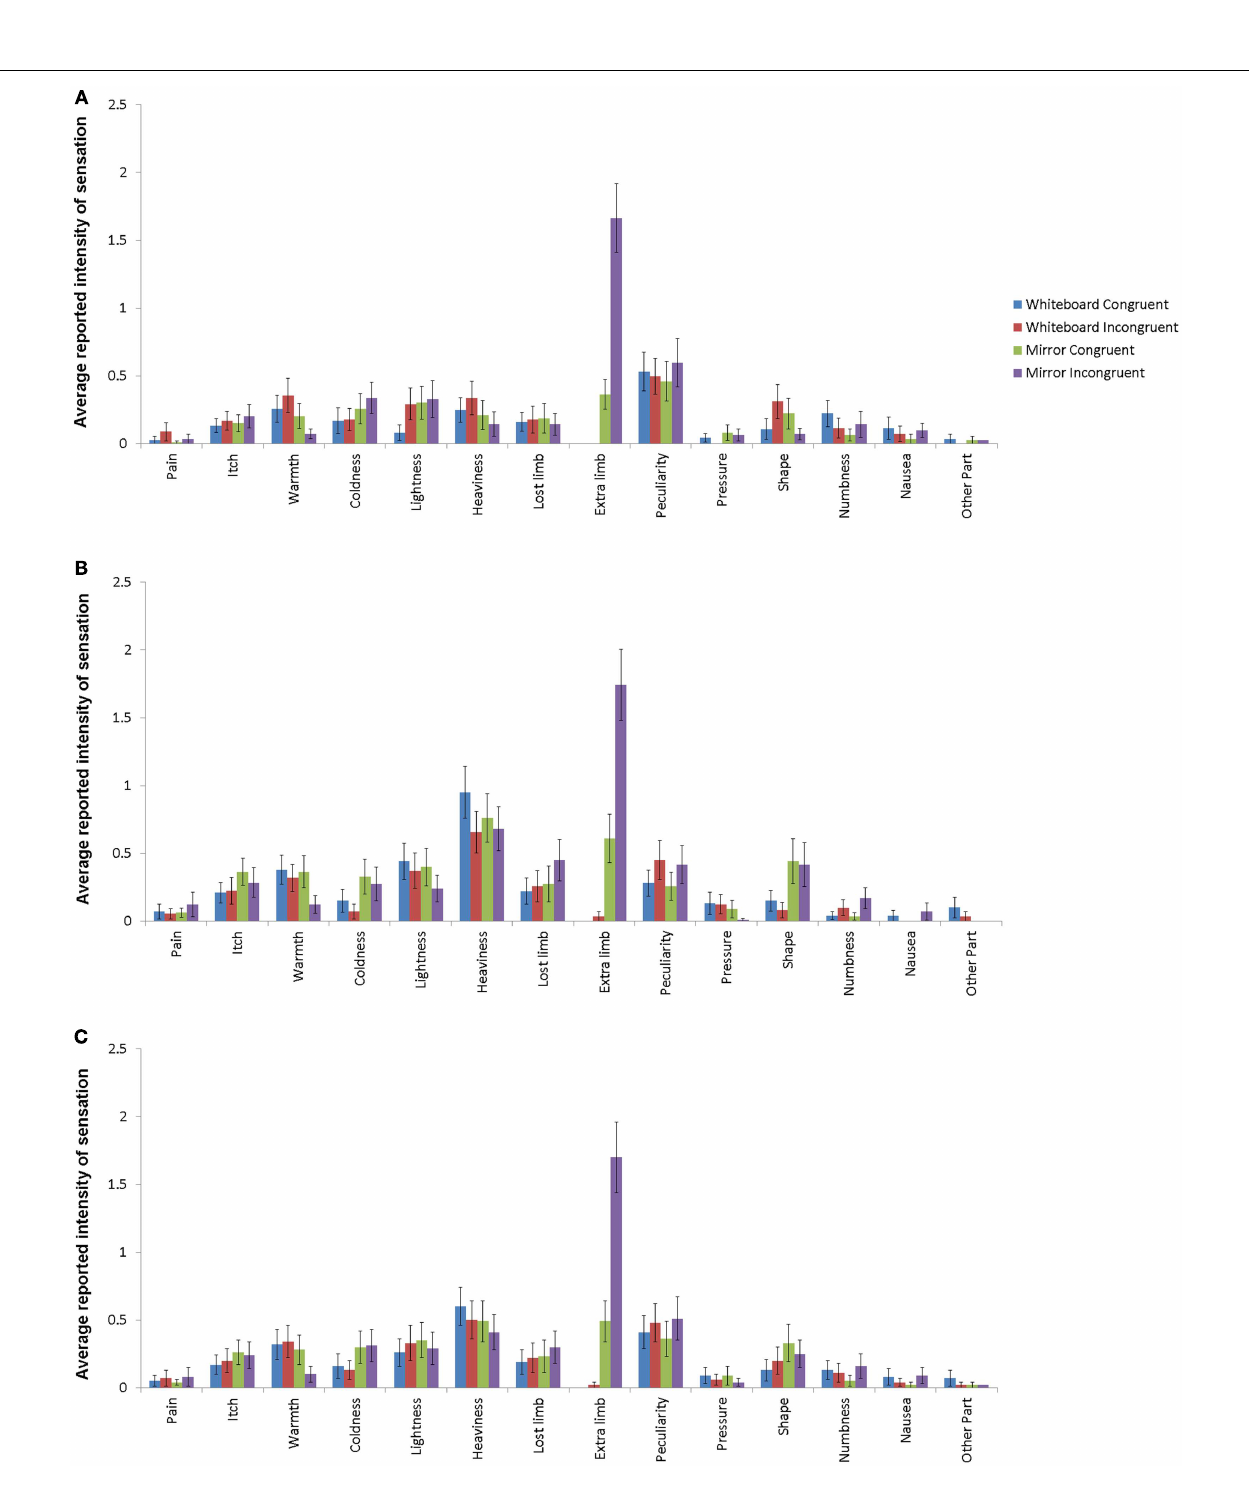
FIGURE 3 | Response intensities for hand conditions (A), arm conditions (B), and average for all conditions (C) with standard error depicted . Different bars indicate different conditions, with mirror/incongruent being the experimental condition. Item definitions are given in Table 1